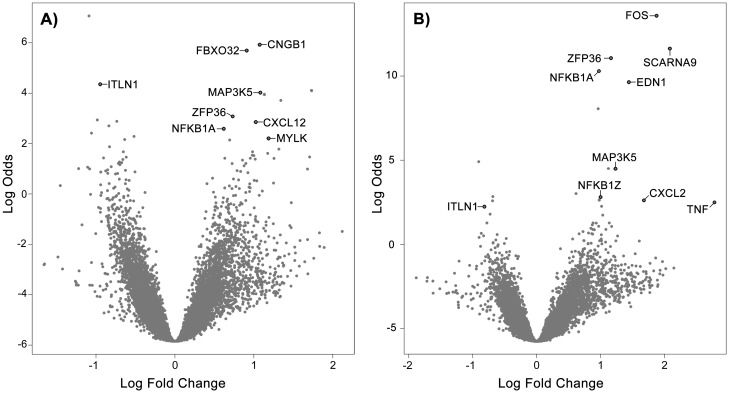
Volcano plots showing differentially expressed genes following incubation of primary mesothelial cells with S. epidermidis isolates for 1 hour.Volcano plots showing differentially regulated genes (adj. p-value < 0.05) following exposure of primary mesothelial cells to S. epidermidis ATCC® 14990 (A) or S. epidermidis ATCC® 12228 (B). A positive Log Fold Change indicates up-regulation; a negative Log Fold Change indicates down-regulation. The Log Odds (B value) is the log of the probability that a gene is differentially expressed. A Log Odds value of 0 corresponds to a 50–50 chance that the gene is differentially expressed.